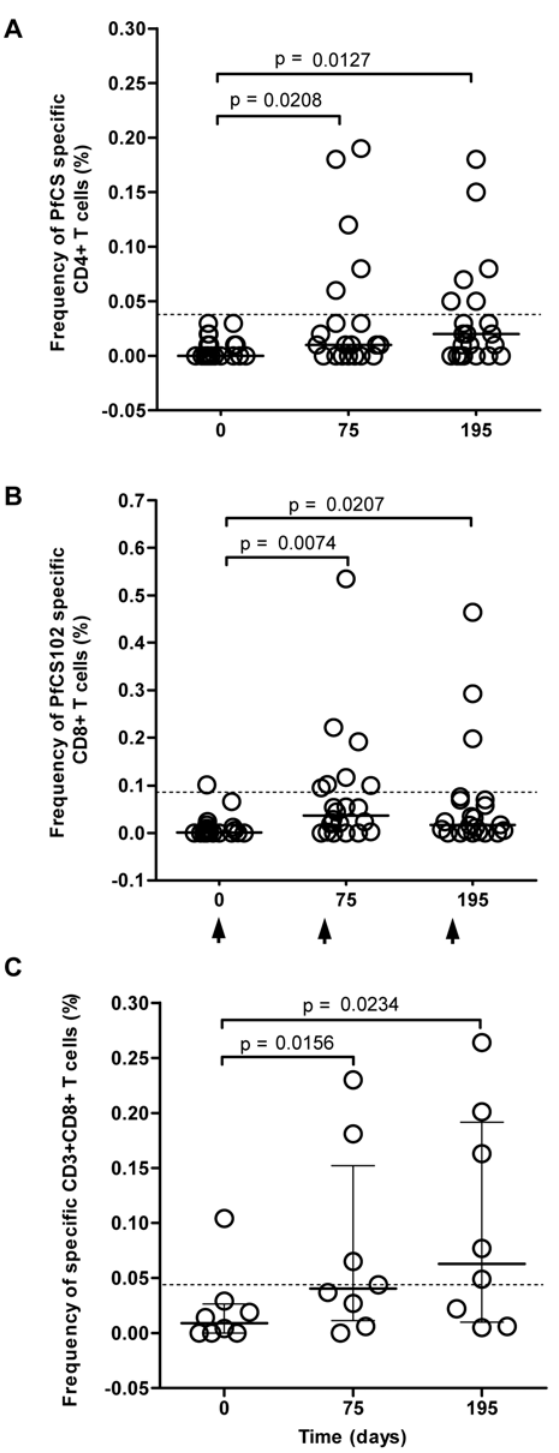
Figure 6. Time-course of individual frequencies of PfCS102 specific T cells. Frequencies were evaluated by intracellular cytokine staining (ICS) using the PBMC of HLA-A2 and/or HLA-A3 volunteers. Results are expressed as percentage of IFN- c positive cells upon PfCS stimulation in the selected cell population: A, CD4 + cells; B, CD8 + cells; C, CD3 + CD8 + T cells (CD16 2 /56 2 , CTL, and CD16 + /56 + , NKT cells) in 8 responders. Dotted lines represent baseline. Statistical analysis was based on Wilcoxon’s test with p , 0.05 as the limit of significance. Arrows indicate the times of vaccination.